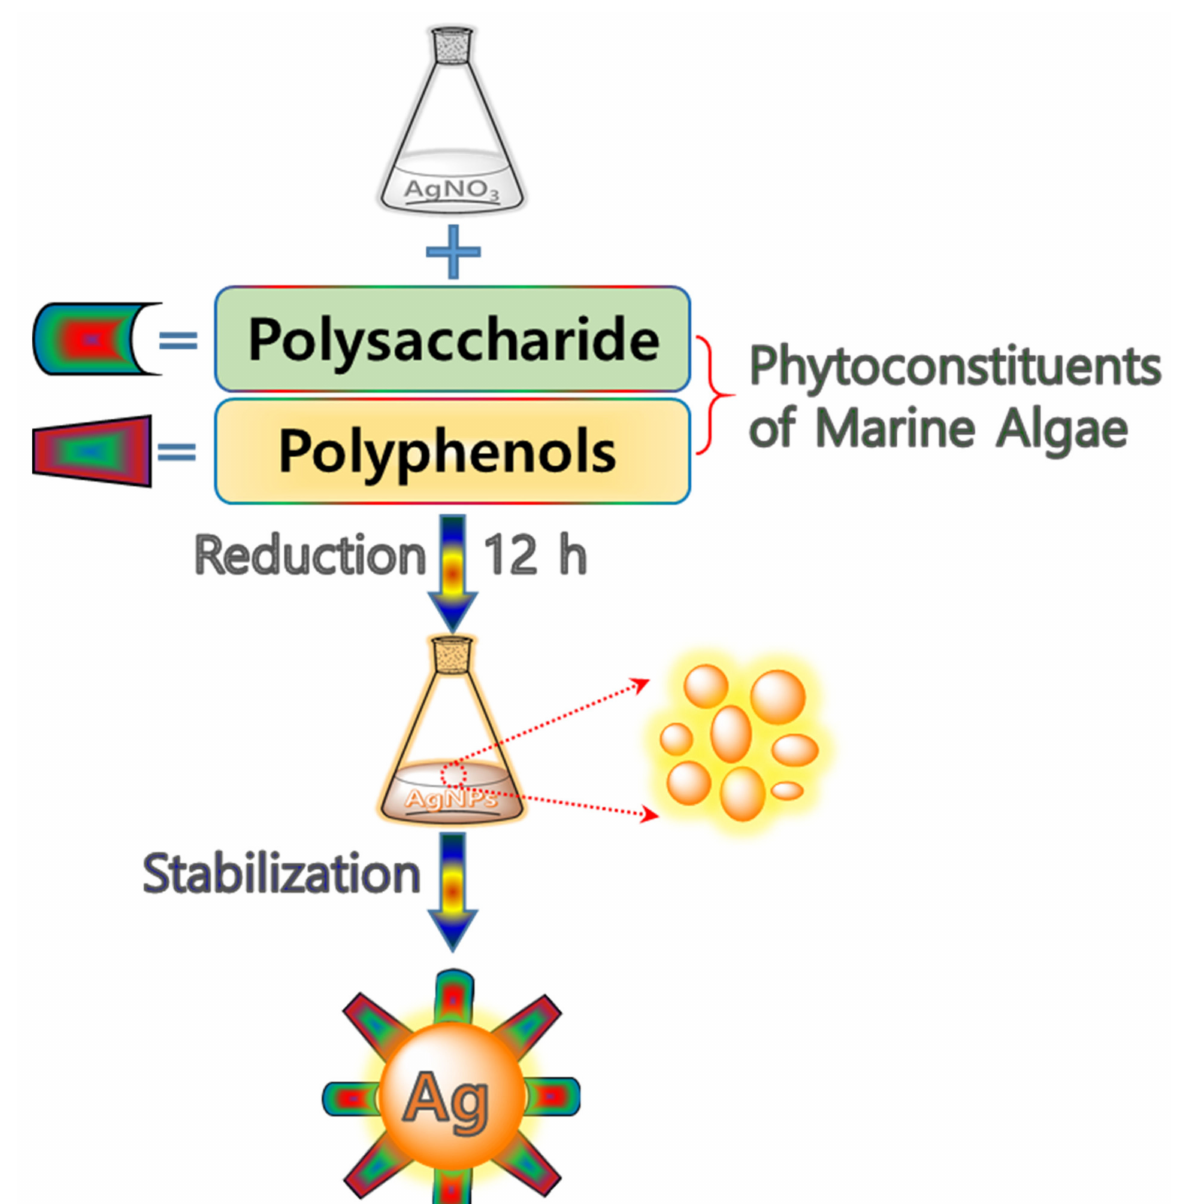
Figure 5. A plausible mechanism of silver nanoparticles synthesis from the extract of Sargassum coreanum